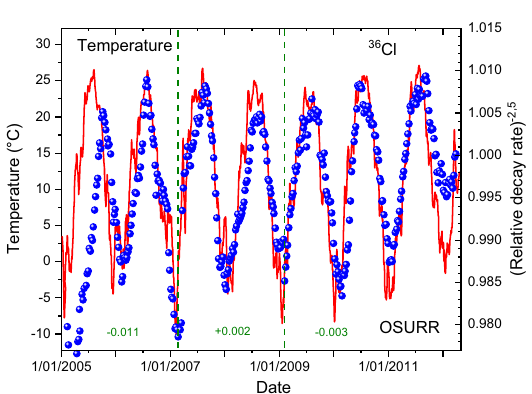
Figure 9. Local shift and power of − 2.5 applied to relative deviations on measured decay rates of 36 Cl at OSURR (dots), compared to temperature data from a nearby weather station